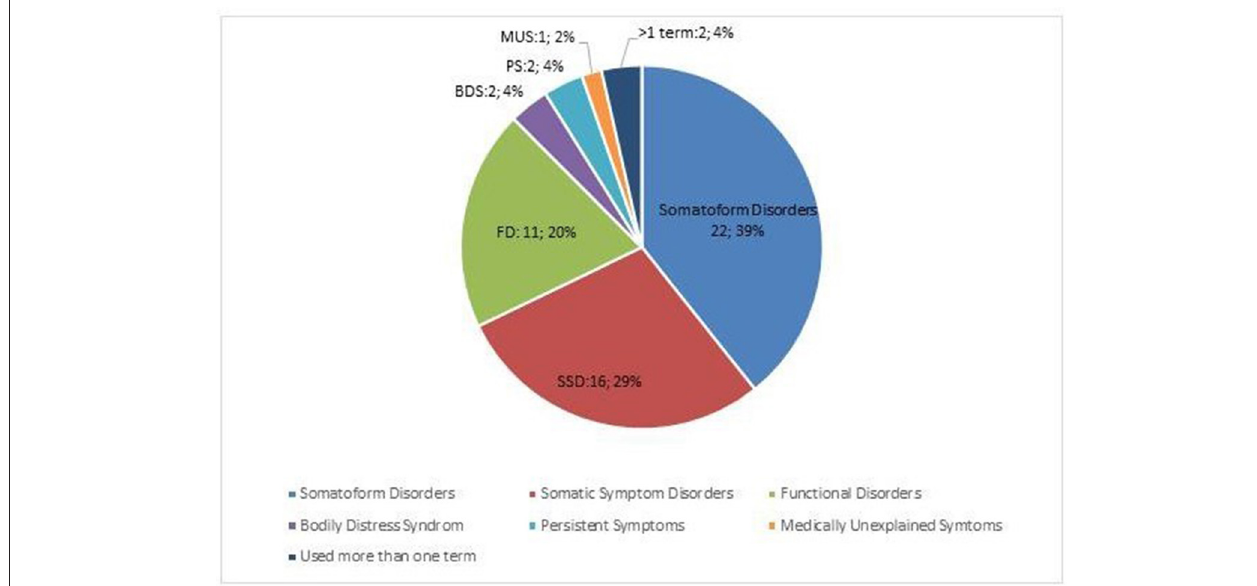
FIGURE 3 | Classifications used by the expert